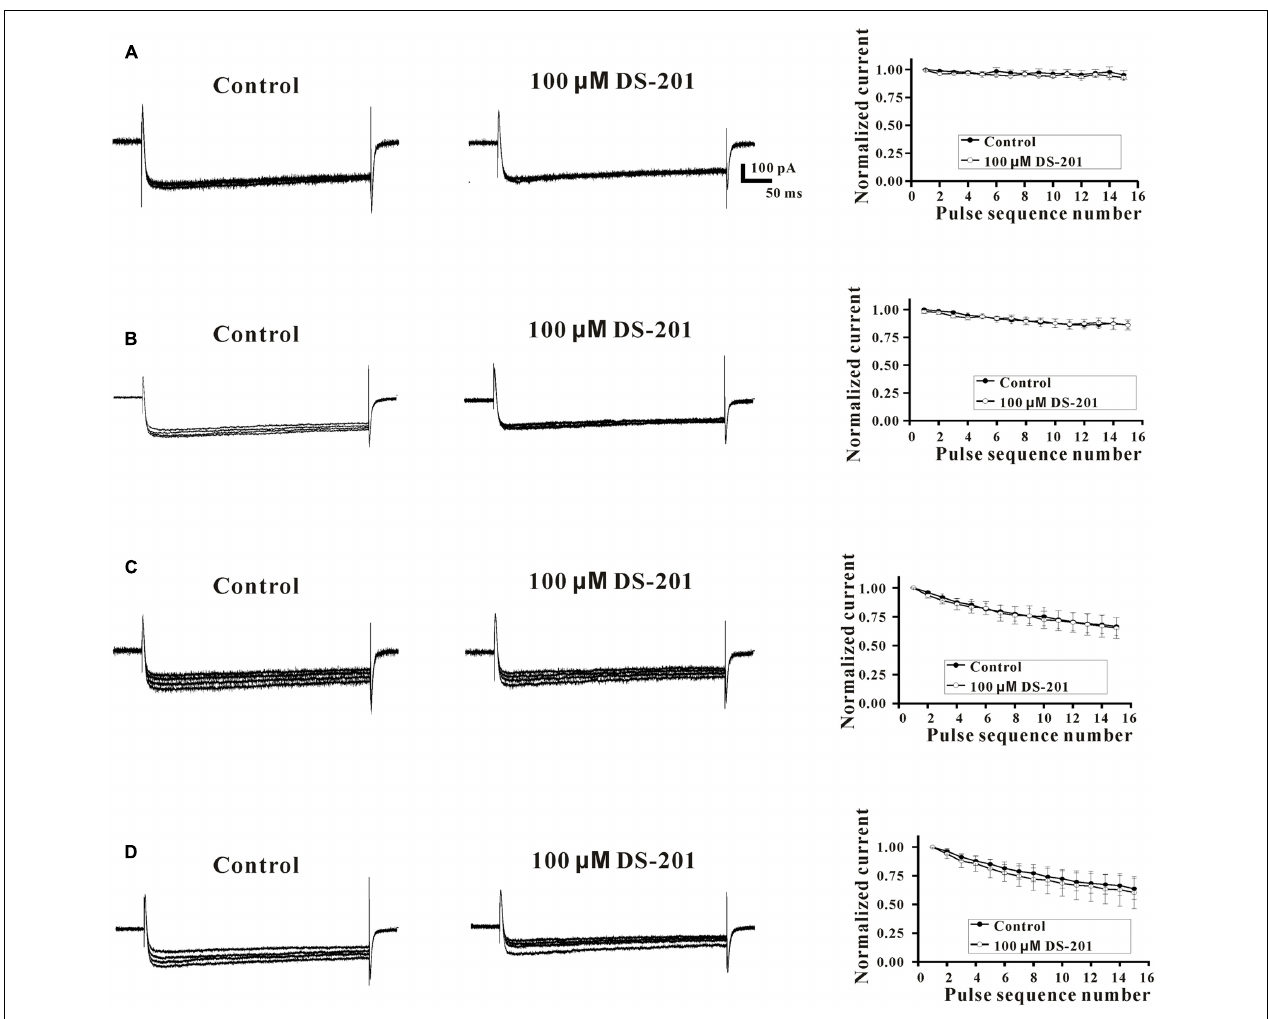
FIGURE 8 | Effect of DS-201 on L-type Ca 2 + channel was rate-independent in L Ca channel-transfected HEK293 cells. Superimposed typical tracings (pulse sequence number: 1, 5, 10, 15) of I Ca , L were obtained at 0.1 (A) , 0.2 (B) , 0.7 (C) , and 2.0 Hz (D) , at –80 mV to + 10 mV membrane potential in the absent or presence of 100 µ M DS-201. The normalized peak currents of I Ca , L (I peak /I peak − firstpulse ) were plotted against each pulse sequence number. The data were obtained from five cells of five experiments.